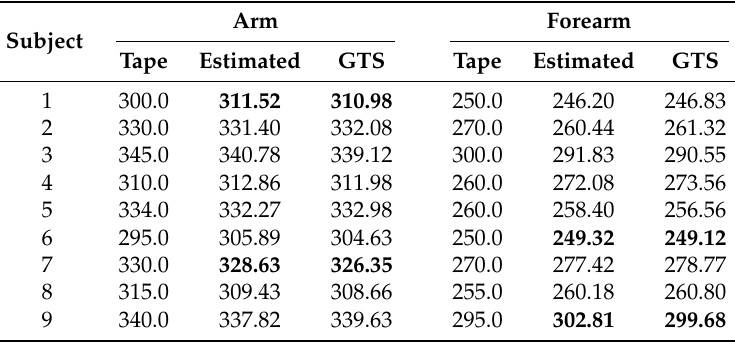
Table 3. Comparison between the estimation made by the proposed algorithm with the ground truth system (GTS) and the tape measure of the arm and forearm lengths of the subjects